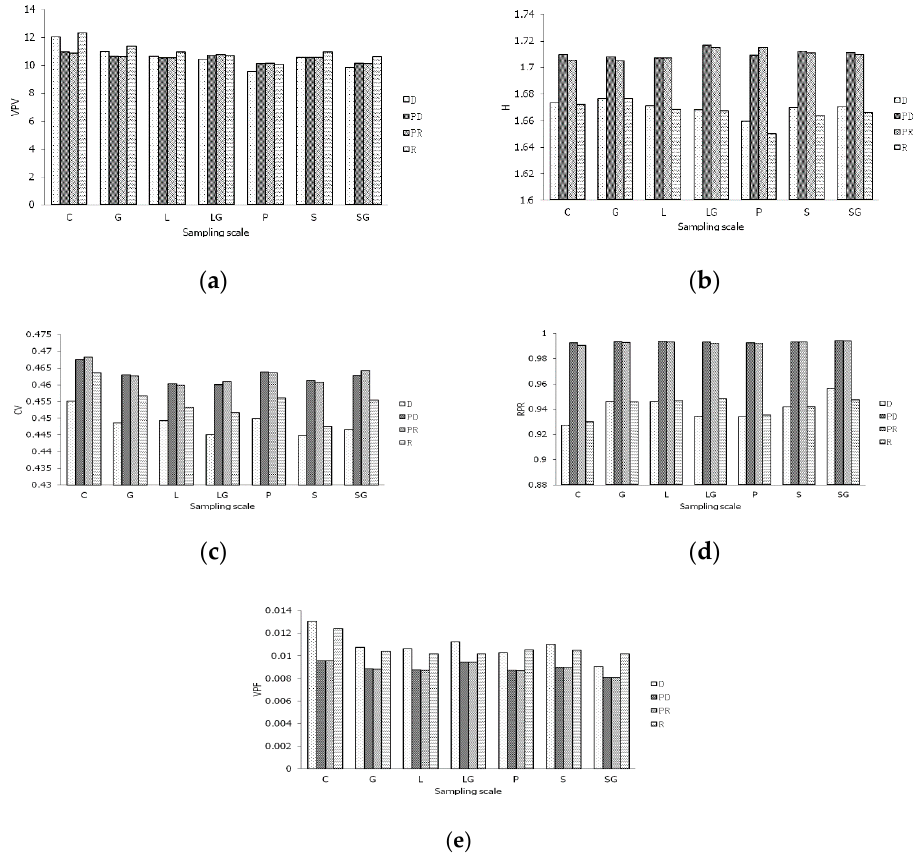
Figure 4. Difference of parameters for sampling strategies in different sampling scale. ( a ) Difference of VPV ; ( b ) Difference of H ; ( c ) Difference of CV ; ( d ) Difference of RPR ; ( e ) Difference of VPF . Shannon–Weaver diversity index ( H ), coefficient of variation ( CV ), variance of phenotypic value ( VPV ), variance of phenotypic frequency ( VPF ), and ratio of phenotype retained ( RPR ). D, PD, PR, R stand for deviation sampling (D), prior and deviation sampling (PD), prior sampling (PR), random clustering (R),